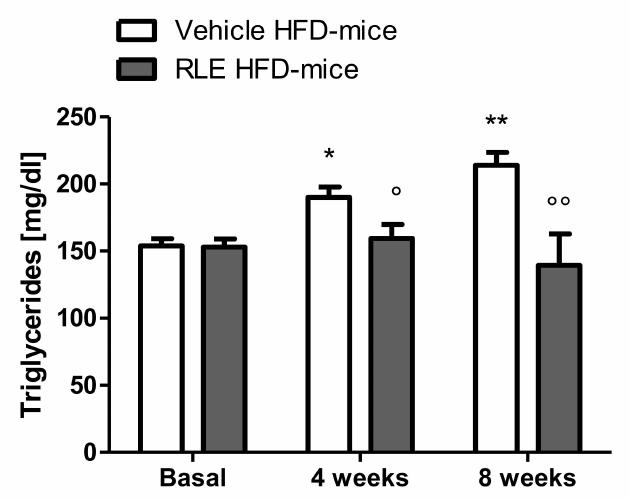
Figure 3. Eight weeks of RLE diet supplementation reduce triglycerides blood concentration in HFD-mice. RLE diet supplementation was able to block blood triglycerides increase in CD1 mice fed on a high-fat diet (HFD-mice) after four and eight weeks of treatment. Data are means ± SEM of 9 to 12 mice per group. Two-way ANOVA followed by Bonferroni post-test. * p < 0.5; ** p < 0.1 vs vehicle